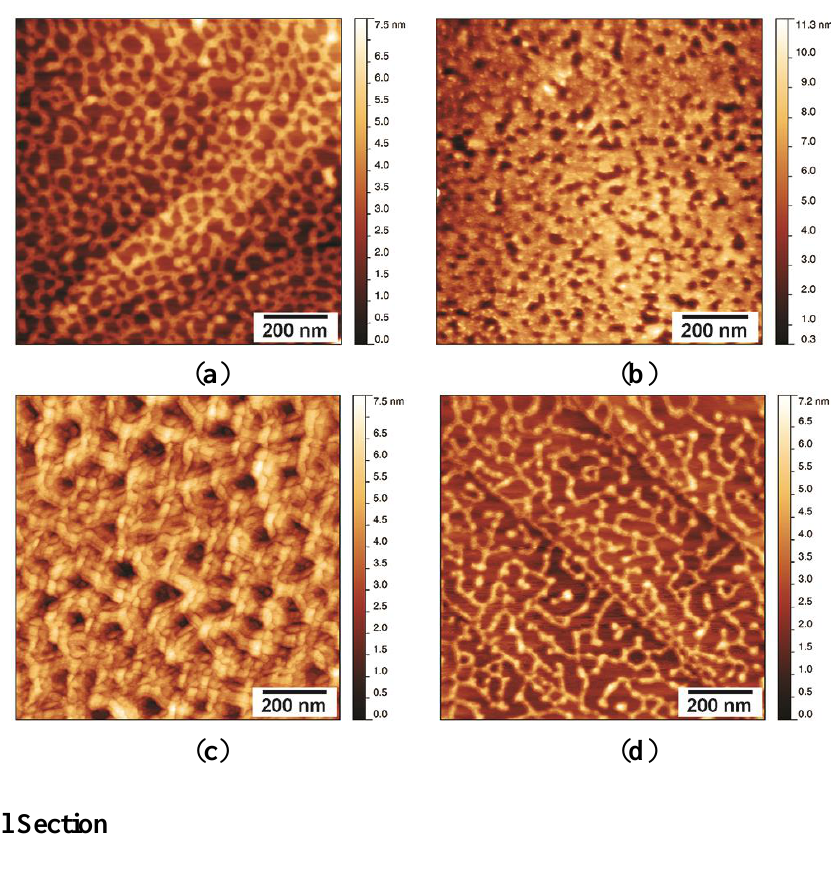
Figure 7. Morphology and stability of NChi2 layers formed from protein at under native conditions: ( a ) NChi2 coating washed with MQW has Class II morphology; ( b ) treatment with 60% ethanol does not disrupt the layer; ( c ) the protein network attached to HOPG is stable towards 3M NaOH; and ( d ) treatment with 3M HCl disrupts interactions between protein molecules, loosening the mesh